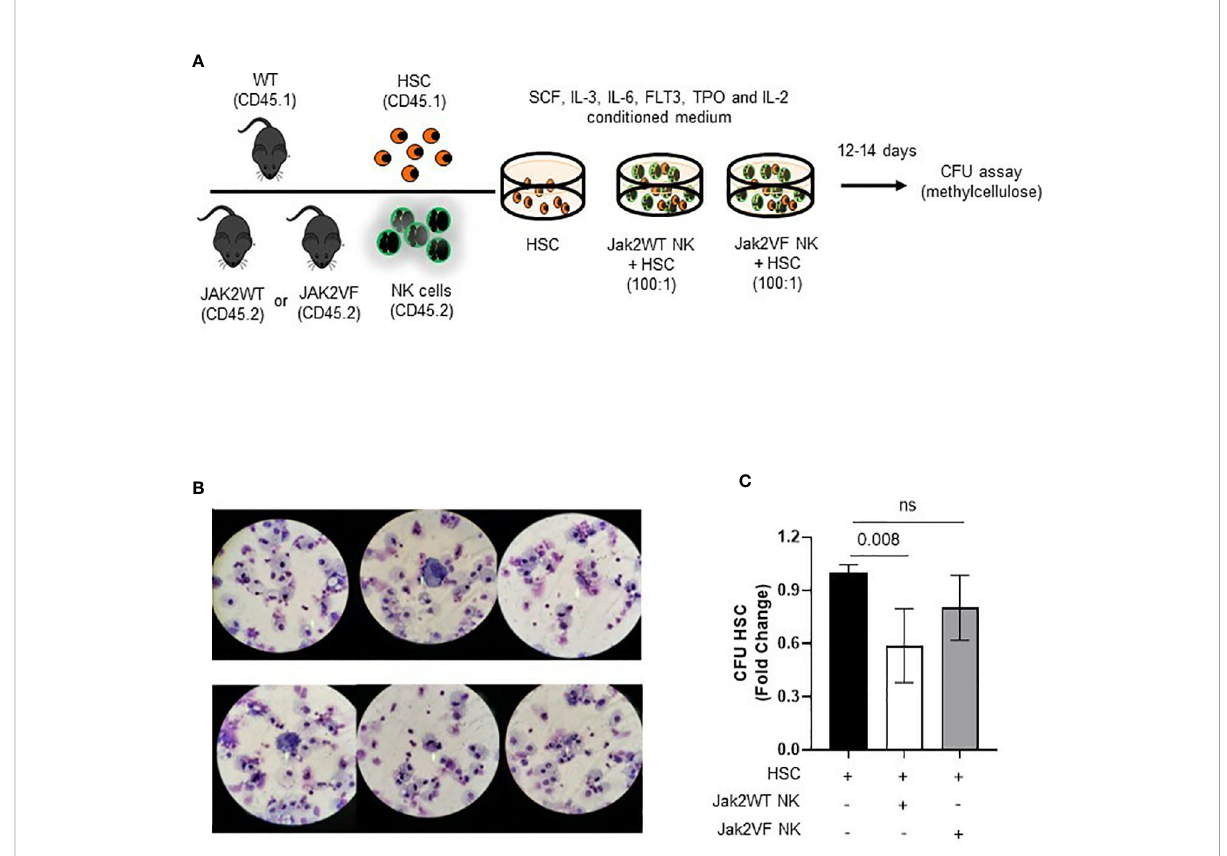
FIGURE 8 NK cells from Jak2V617F mice are de fi cient in regulating the differentiation and clonogenic capacity of hematopoietic stem cells (HSC). (A) Schematic fi gure of the strategy used to study the NK-HSC interaction in culture. (B) Illustrative image of co-culture cytospins showing HSC (LSK SLAM + cells) differentiation after 12 days of methylcellulose colony assay. The majority of CFU-derived cells corresponded to macrophages and granulocytic progenitors. (C) Graphic representation of the quanti fi cation of colony forming units (CFU) expressed as fold change in the following conditions: HSC, Jak2WT NK cells + HSC, Jak2VF NK cells + HSC. VF: Jak2V617F mutated; WT: Jak2 wild-type. CTRL: Control; MPN: myeloproliferative neoplasms. PV: polycythemia vera; ET: essential thrombocythemia; PMF: primary myelo fi brosis. Error bars indicate the mean (± SEM). NS, not signi fi cant ( p < 0.05), Kruskal Wallis